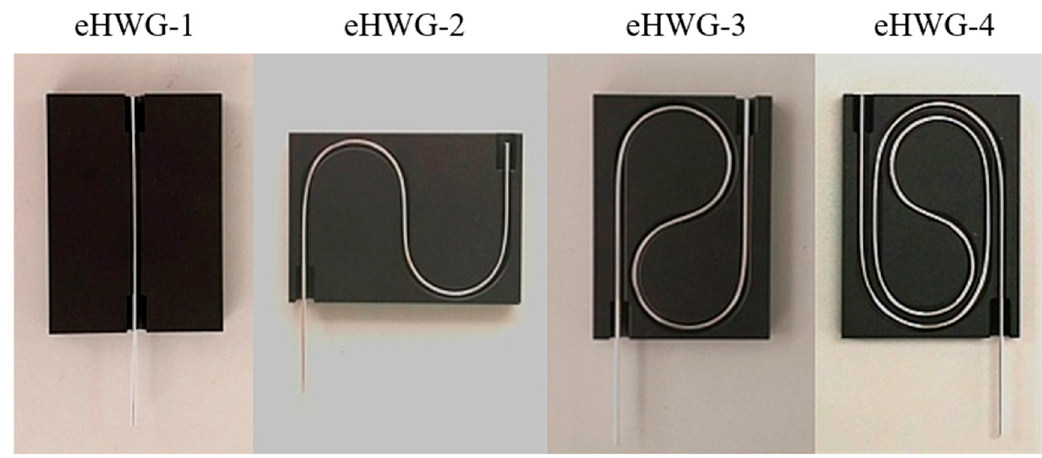
Figure 2. eHWG (no. 1 to 4) with flexible waveguide.